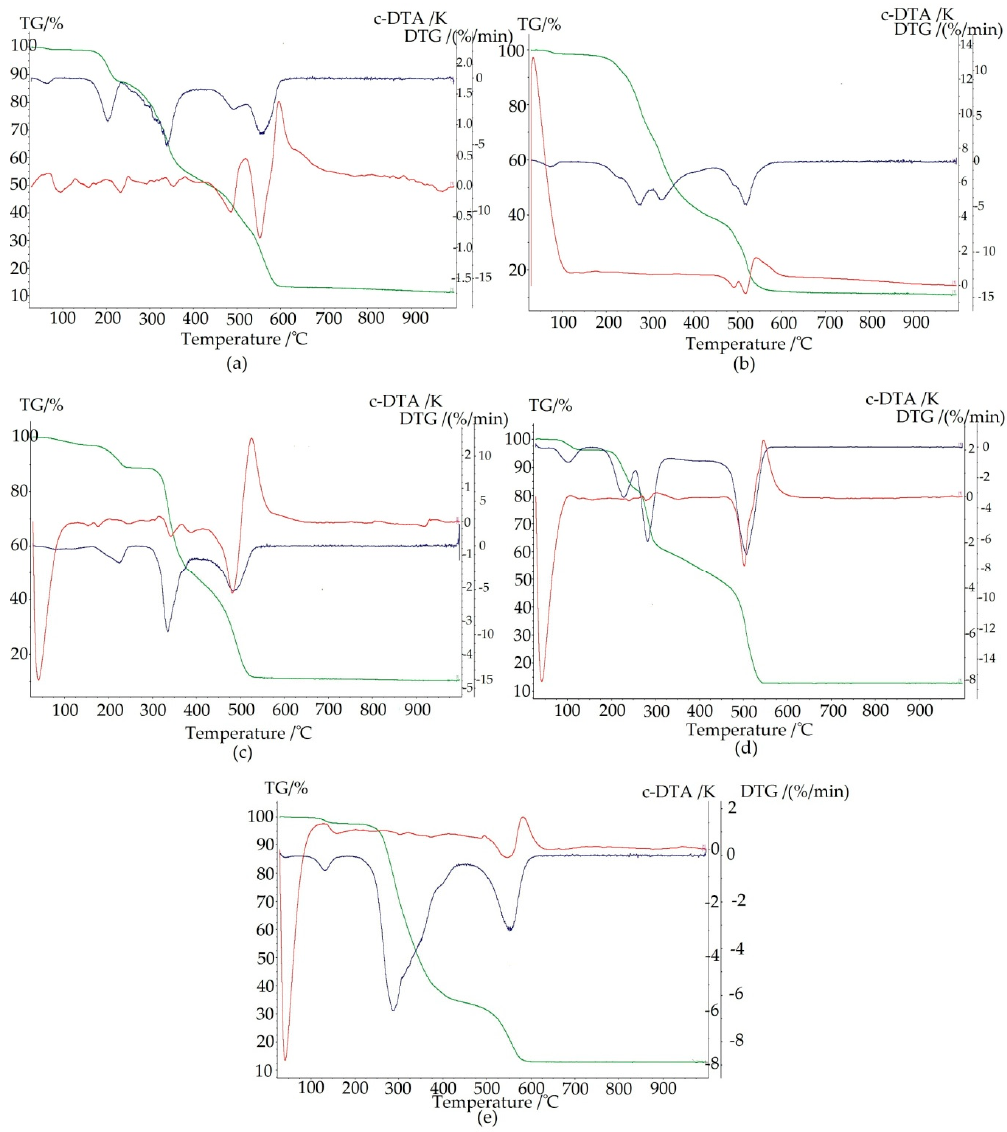
Figure 5. Thermoanalytical curves for 1 ( a ), 2 ( b ), 3 ( c ), 4 ( d ) and 5 ( e ). TG is plotted in green, DTG is in blue, while DTA is in red. blue, while DTA is in